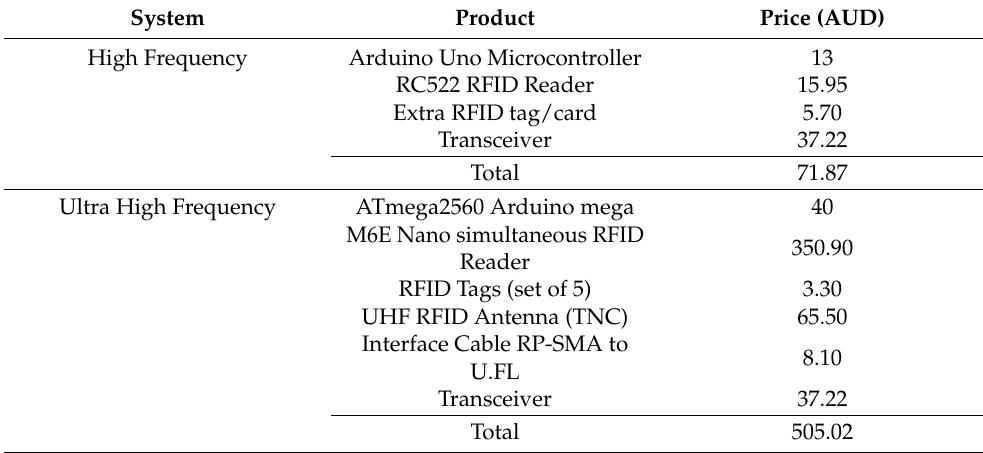
Table 3. RFID contact tracing system hardware components and their